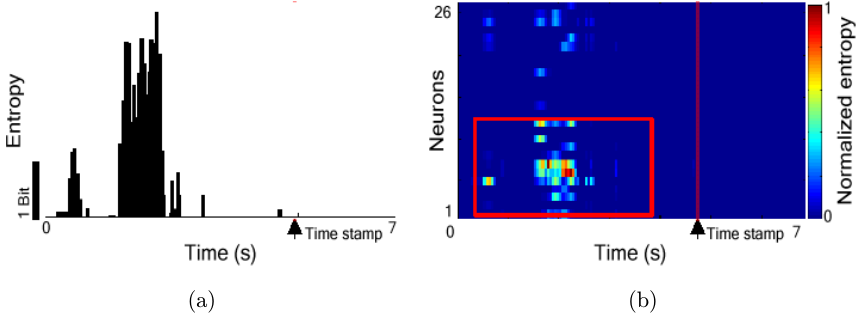
Fig. 5. Neuronal ensemble sparse coding during the working memory task. (a) Histogram of sparse reconstructed neuronal population ¯ring entropy. (b) Neuronal ensemble sparse